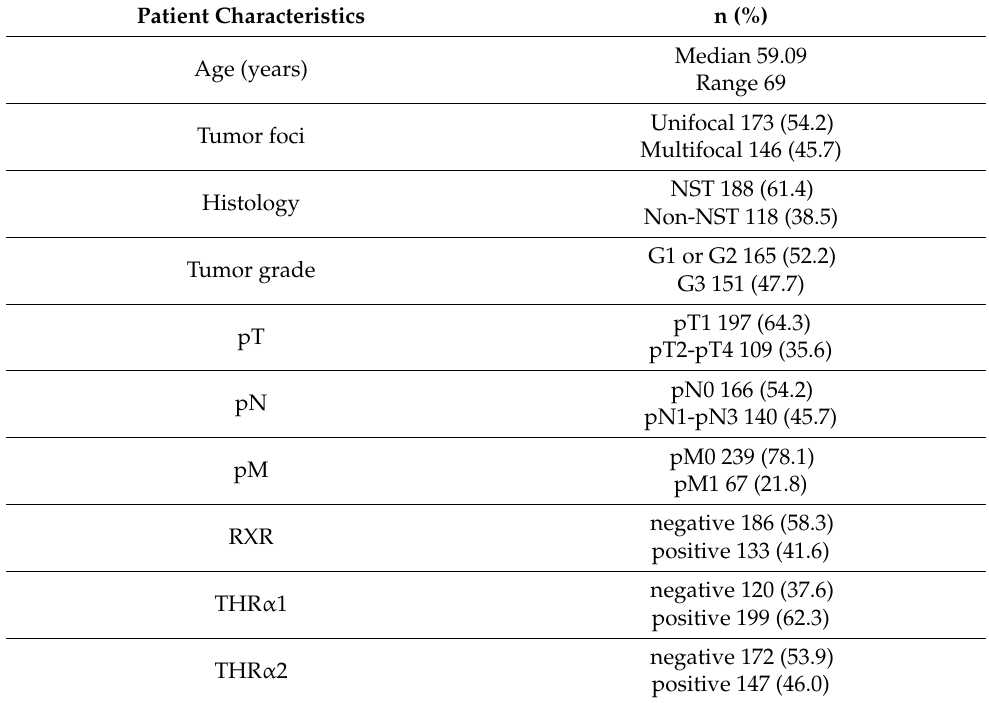
Table 4. Patient characteristics of the total